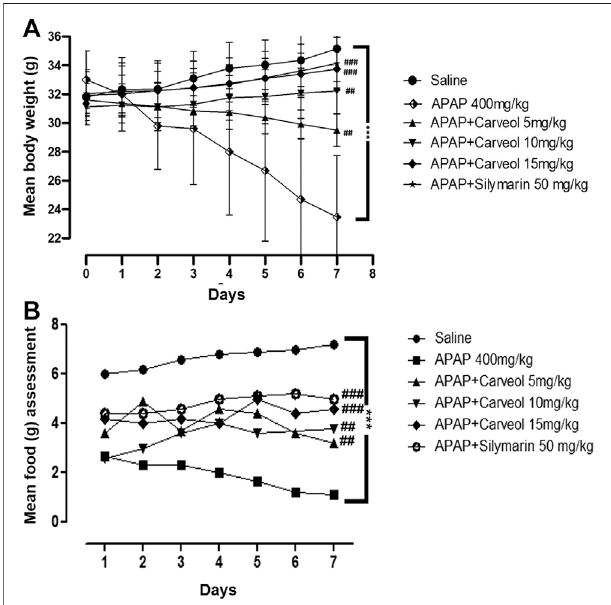
Figure 3 | Effect of carveol treatment on physical parameters, such as body weight and food intake. (A) Bodyweight changes (B) Mean food intake. The number of animals was 14/group, and the results were analyzed using a repeated two-way ANOVA test. ### p < 0.001, ## p < 0.01 compared to the APAP group, *** p < 0.001, compared to the saline